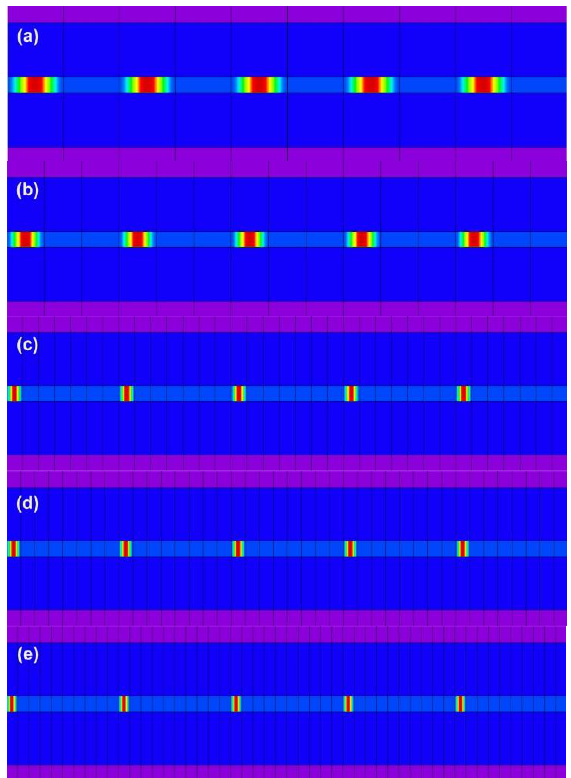
Figure 2. SFBG design patterns for numerical simulation and computation. ( a ) duty cycle = 50%; ( b ) duty cycle = 33.33%; ( c ) duty cycle = 14.28%; ( d ) duty cycle = 12.5%; ( e ) duty cycle = 10%.